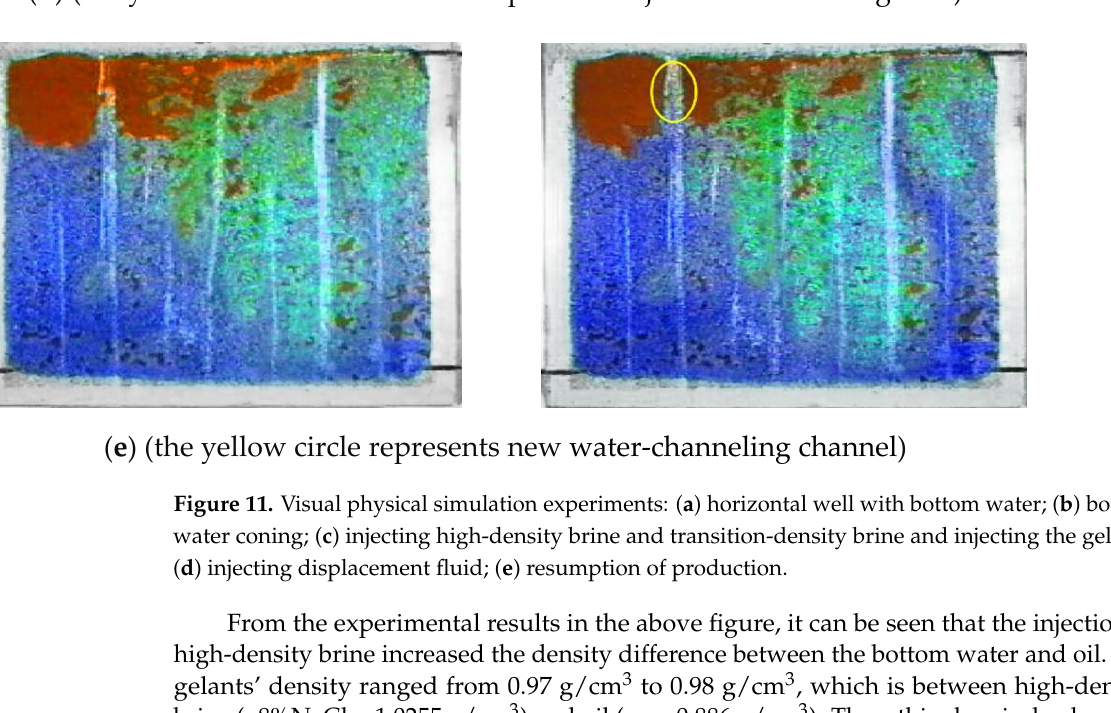
( d ) (the yellow circle and the arrow represents injection channel of gelant)